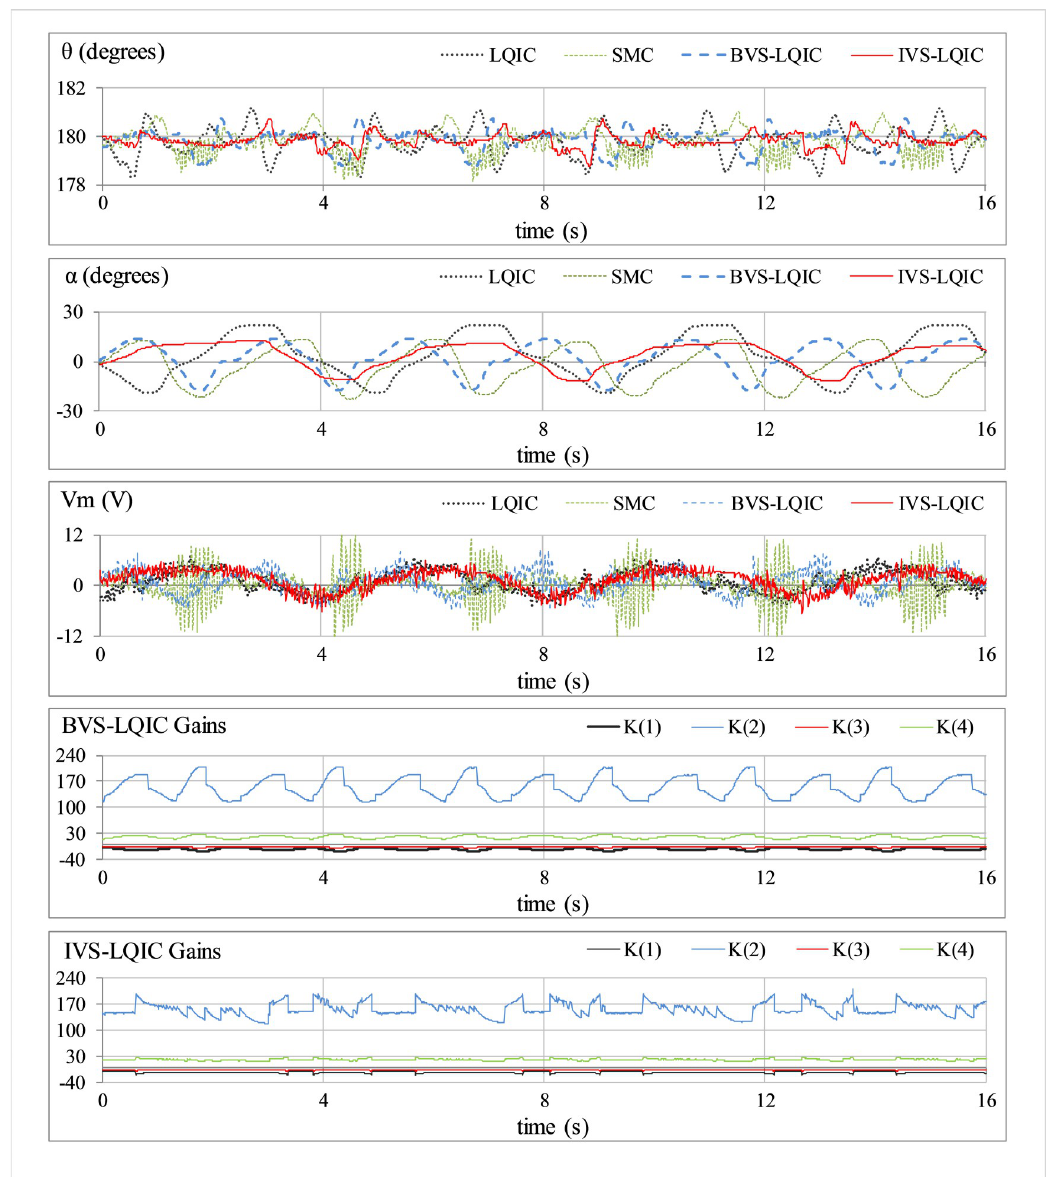
Fig 7. Pendulum’s response under normal